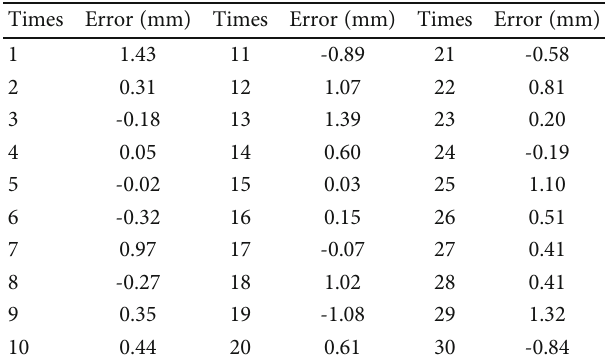
Table 2: Positioning error of hydraulic rod with 40mm movement distance.